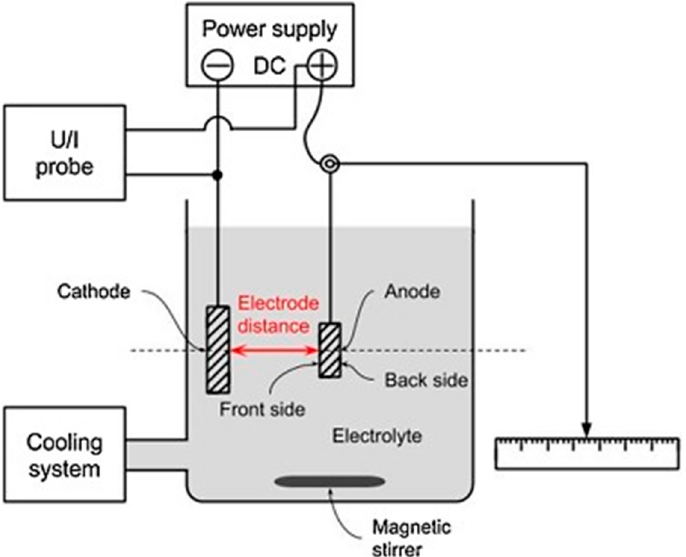
Figure 18. Sketch of the PEO experimental setup with stainless steel as a cathode and AM50 alloy as anode. Reproduced with permission from [151]. Copyright Elsevier, 2016.